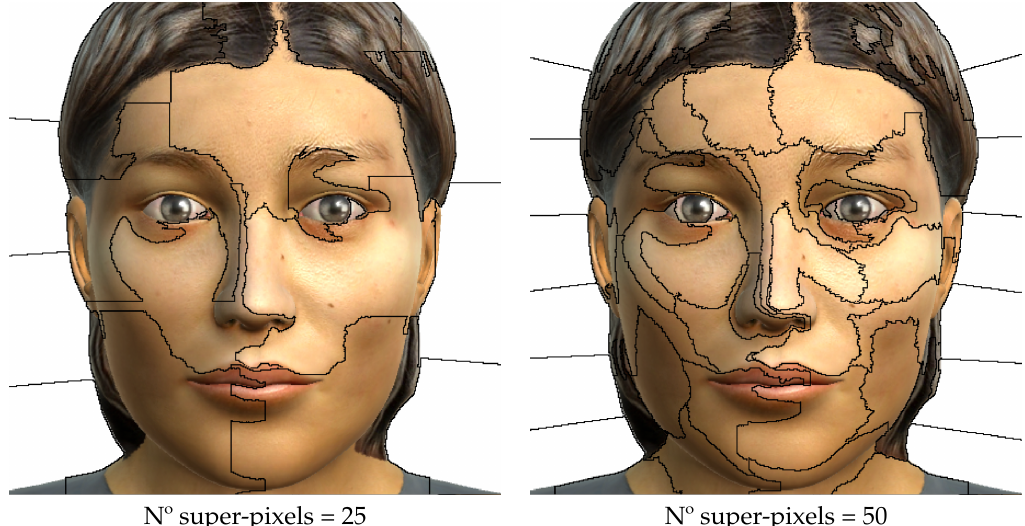
Figure 2. Example of the configuration of the number of super-pixels to segment into.